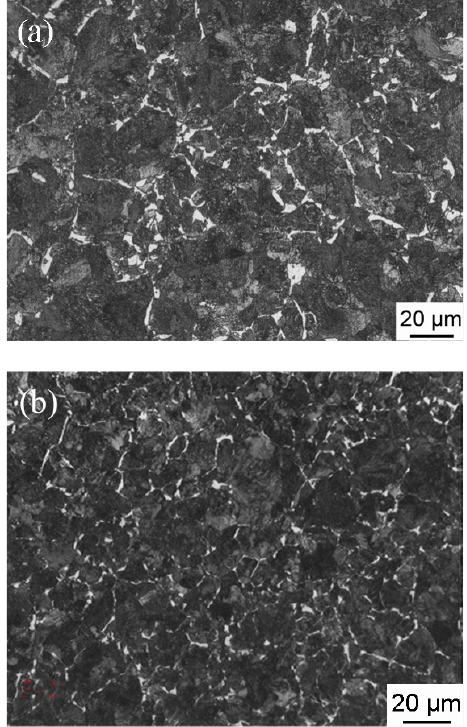
Figure 3. OM micrographs of the two tested wheel steels, ( a ) J12 and ( b )